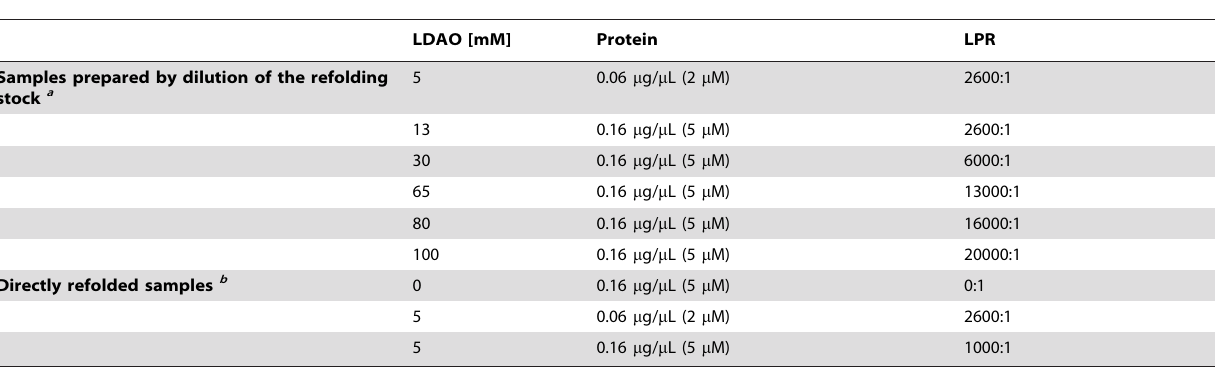
Table 1. Summary of the samples and LPRs used in this study.